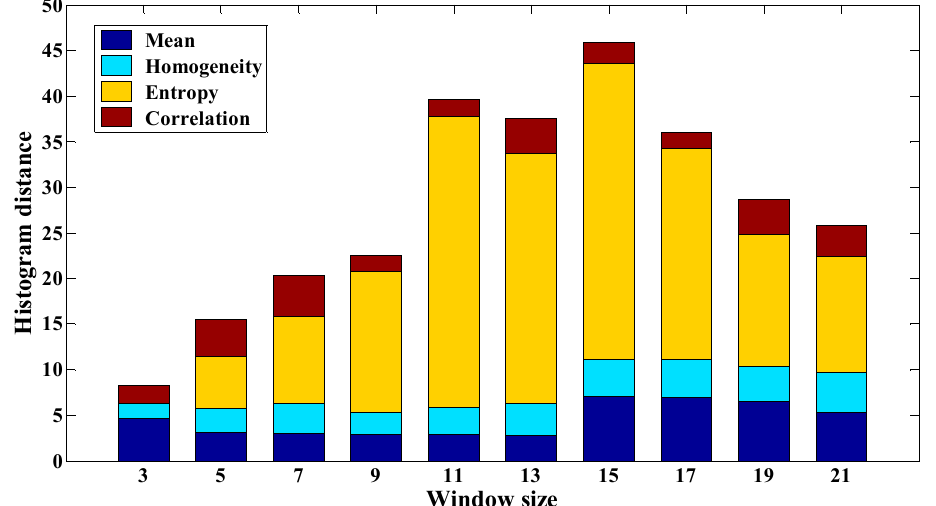
Figure 12. Stacked bar chart of the histogram distance between CB and OB for the four texture features with di ff erent window sizes.